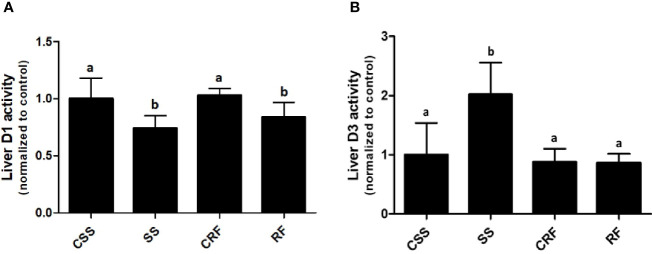
D1 (A) and D3 (B) activities in liver. CSS, control of semi-starved rats; SS, semi-starved rats; CRF, control of refed rats; RF, refed rats. D1 activity ranged from 270 to 500 fmol/min/mg. D3 activity ranged from 0.1 to 0.8 fmol/min/mg. Data were normalized to the value obtained for CSS animals (set as 1). (A, B: n= 8-10). Results are shown as mean values ± SD. Multiple comparisons between the groups were statistically evaluated by 1-way ANOVA followed by the Newman–Keuls test. Bars labeled with dissimilar letters are significantly different; in (A), SS vs. CSS and SS vs. CRF, p<0.001; RF vs. CRF and RF vs. CSS, p<0.01; in (B), SS vs. CSS, SS vs. CRF, and SS vs. RF, p<0.001.